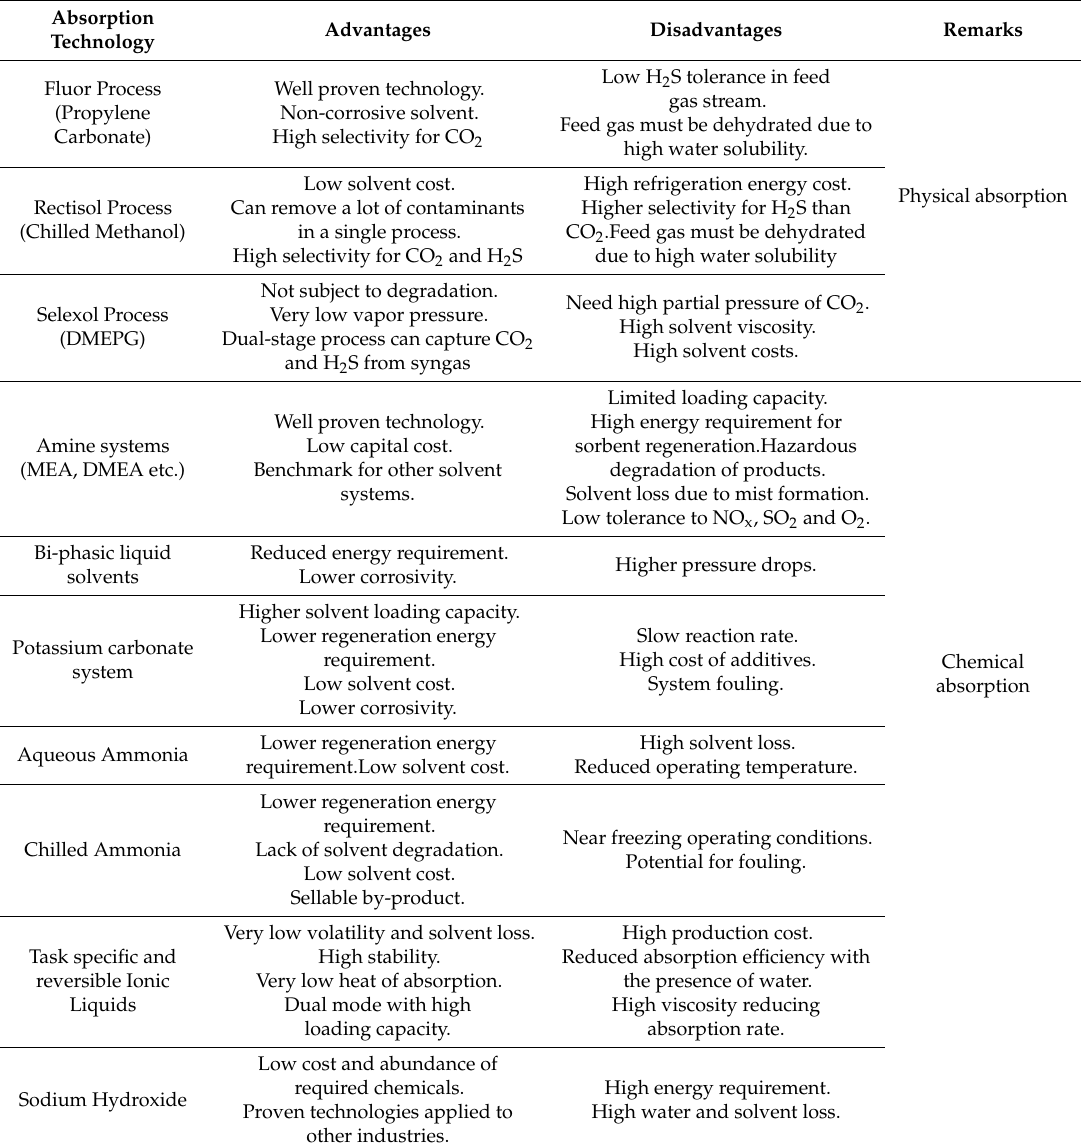
Table 4. Advantages and disadvantages of di ff erent absorption technology